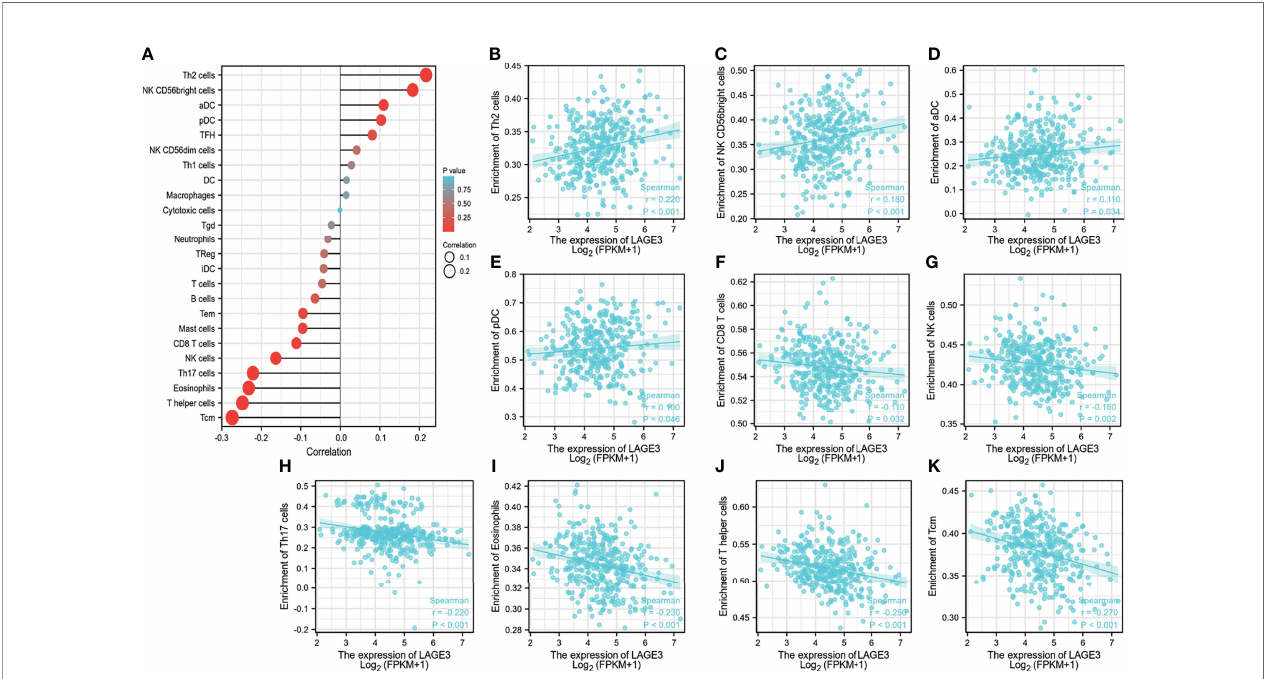
FIGURE 6 | LAGE3 expression correlates with immune cell in fi ltration in HCC. (A) From TCGA database, the correlation of LAGE3 expression with 24 types of immune cells in HCC based on the Gene Set Variation Analysis (GSVA). (B-K) From TCGA database, the correlation of LAGE3 expression with (B) Th2 cells;